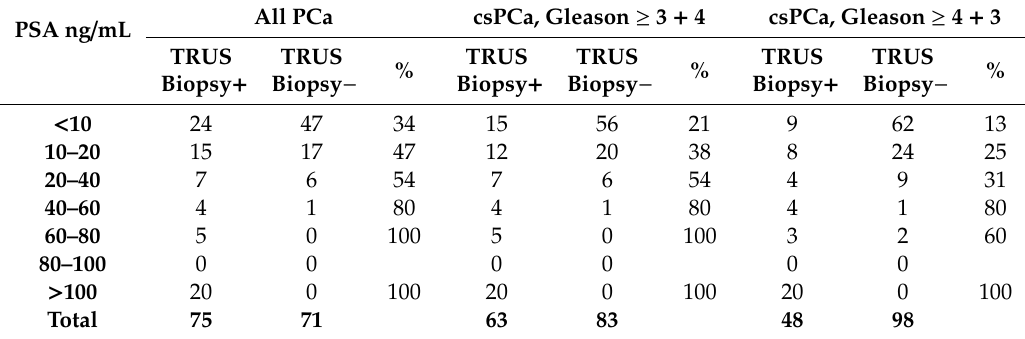
Table 2. Number of men with no cancer and clinically significant prostate cancer (primary and secondary definition) on TRUS biopsy. Clinically significant prostate cancer was defined based on the patients’ clinicopathologic factors as described in patients and methods. PCa: prostate cancer; csPCa: clinically significant prostate cancer; PSA: prostate-specific antigen; TRUS biopsy: transrectal ultrasound-guided